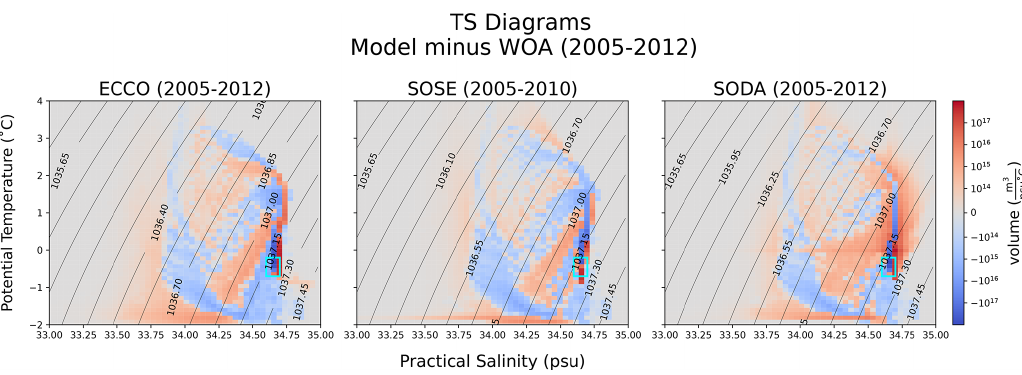
Figure 4. Averaged temperature–salinity distribution of the difference between WOA and each model. Contour lines represent potential density referenced at 2000m ( σ 2 ). The cyan box shows the temperature–salinity range of